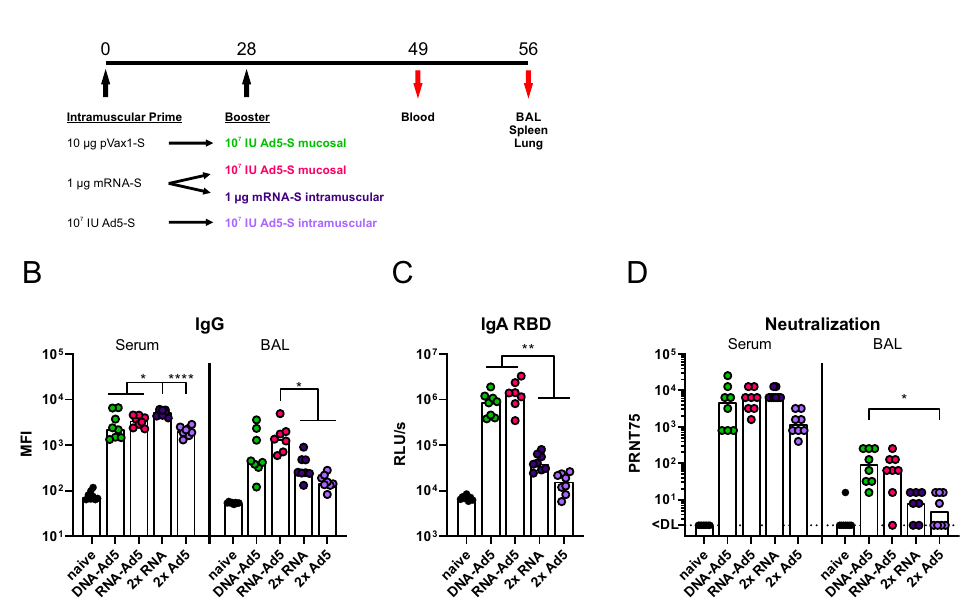
Fig. 5 Humoral responses after homologous or heterologous prime-boost vaccination. A C57BL/6 mice received an intramuscular prime immunization with the spike-encoding DNA (10 µ g), Ad5-S (10 7 infectious units), or the mRNA vaccine, Comirnaty ® (1 µ g). Mice from the heterologous prime-boost groups were boosted four weeks later intranasally with Ad5-S (10 7 infectious units). The homologous prime-boost groups received a second dose of mRNA (1 µ g) or Ad5-S (10 7 infectious units) intramuscularly. Serum antibody responses were analysed 21 days and mucosal immune responses four weeks after the boost immunizations. Spike-speci fi c IgG ( B ) were assessed by a fl ow cytometric approach (dilutions: Sera 1:800, BAL 1:20). BAL samples were tested for spike-speci fi c IgA directed against RBD by ELISA ( C ). Plaque reduction neutralization titres (PRNT75) were determined by in vitro neutralization assays ( D ). Bars represent group medians overlaid with individual data points; sera all groups n = 8; BALs RNA-Ad5 n = 7, other groups n = 8 (out of two independent experiments). Data were analysed by one-way ANOVA followed by Tukey ’ s post test ( B and C ) or Kruskal – Wallis test (one-way ANOVA) followed by Dunn ’ s multiple comparison test ( D ). Statistically signi fi cant differences are indicated only among the different vaccine groups; p values indicate signi fi cant differences (* p < 0.05; ** p < 0.005; *** p < 0.0005; **** p <